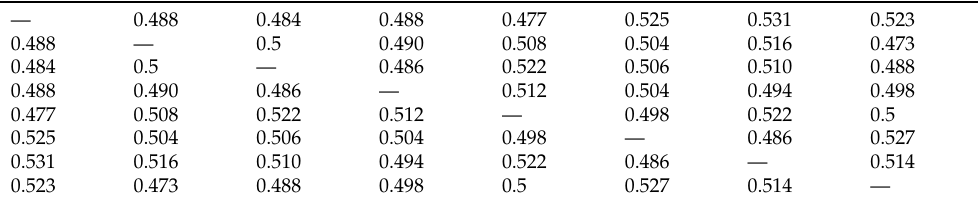
Table 6. Dependence matrix with entries d ij .